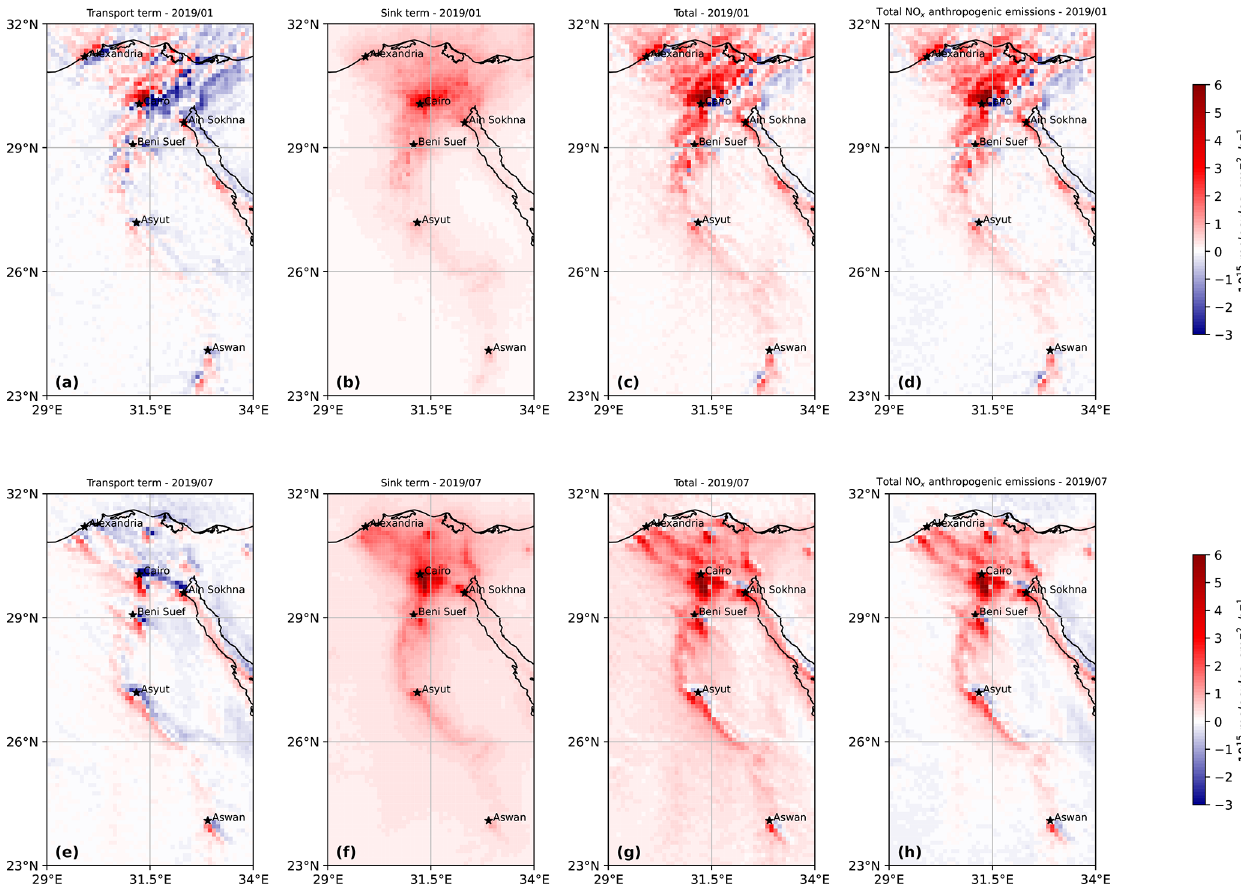
Figure 6. NO x emissions above most of Egypt’s territory: (a–d) transport term (a) , sink term (b) , resulting emissions (c) and the correspond- ing anthropogenic emissions after non-anthropogenic background removal (d) for January 2019. (e–h) Transport term (e) , sink term (f) , resulting emissions (g) and the corresponding anthropogenic emissions after background removal (h) for July 2019. Table 1. Comparison between the transport term and the sink term above different cities in Egypt, as well as the industrial region of Ain Sokhna located 45km southwest of Suez for January and July 2019. TROPOMI vertical NO 2 columns, NO x emissions and population densities correspond to average values within 18km from the city centre. Unit M stands for a quantity of 10 15 molecules (NO 2 or NO x ). City Population density Jan 2019 Jul 2019 (inhabitants per (cid:127) NO Transport (cid:127) NO 2